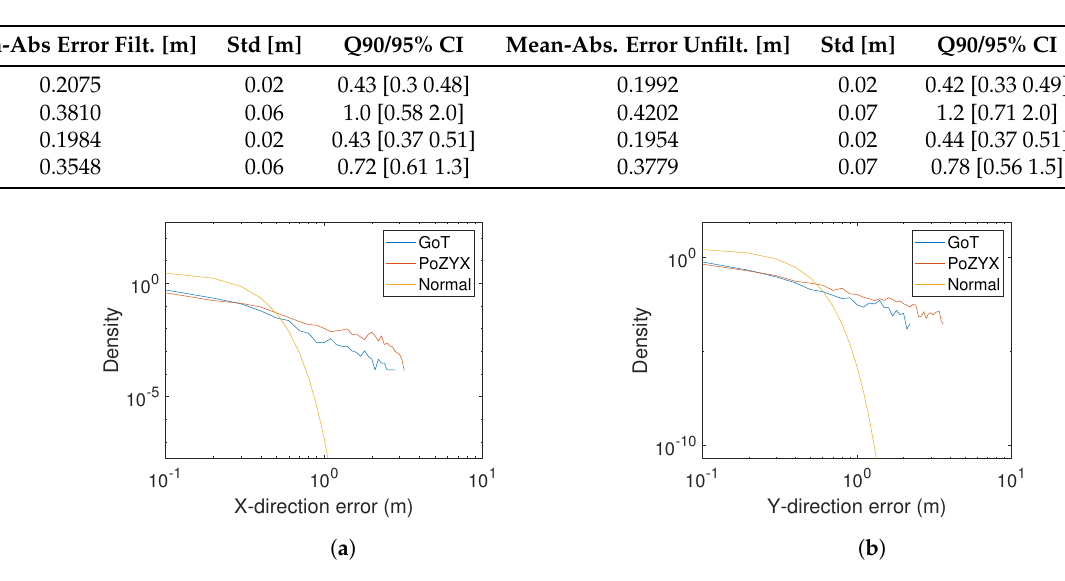
Table 4. Filtered and unfiltered mean-absolute errors for X- and Y-directions.